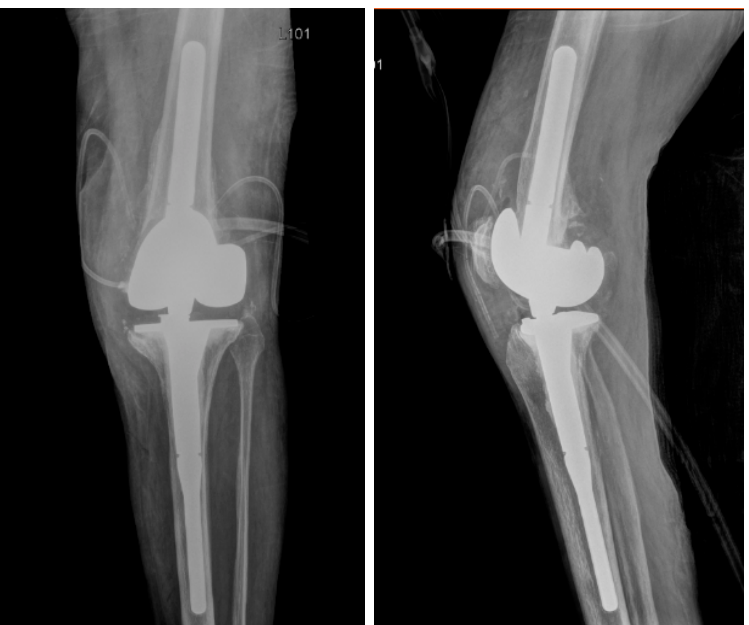
Figure 2. Post-operative anterior–posterior and lateral X-ray showing well fixed long stem femoral and tibial arthroplasty components. No hardware complication is present but generalized osteopenia and expected postoperative changes with intra-articular emphysema. Surgical drain is also noted.